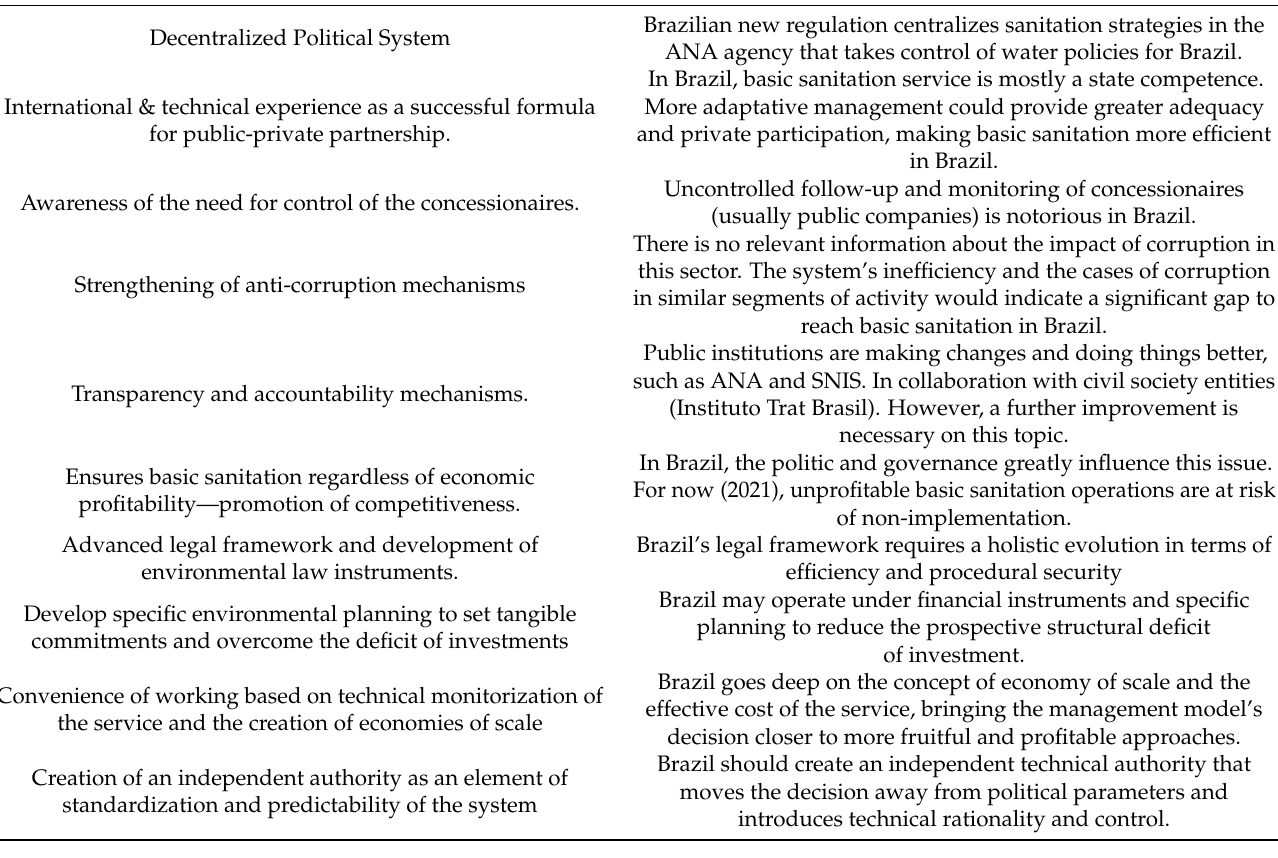
Table 1. Comparative factors that may contribute to a more efficient water and sanitation system